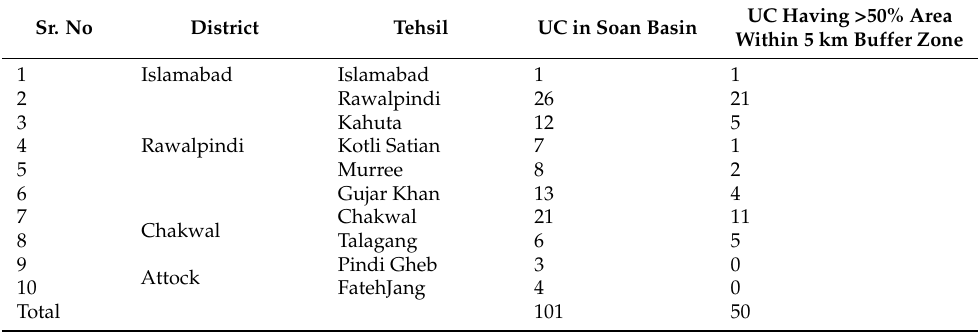
Table A1. Teshil wise Union Councils under applied buffer Zone